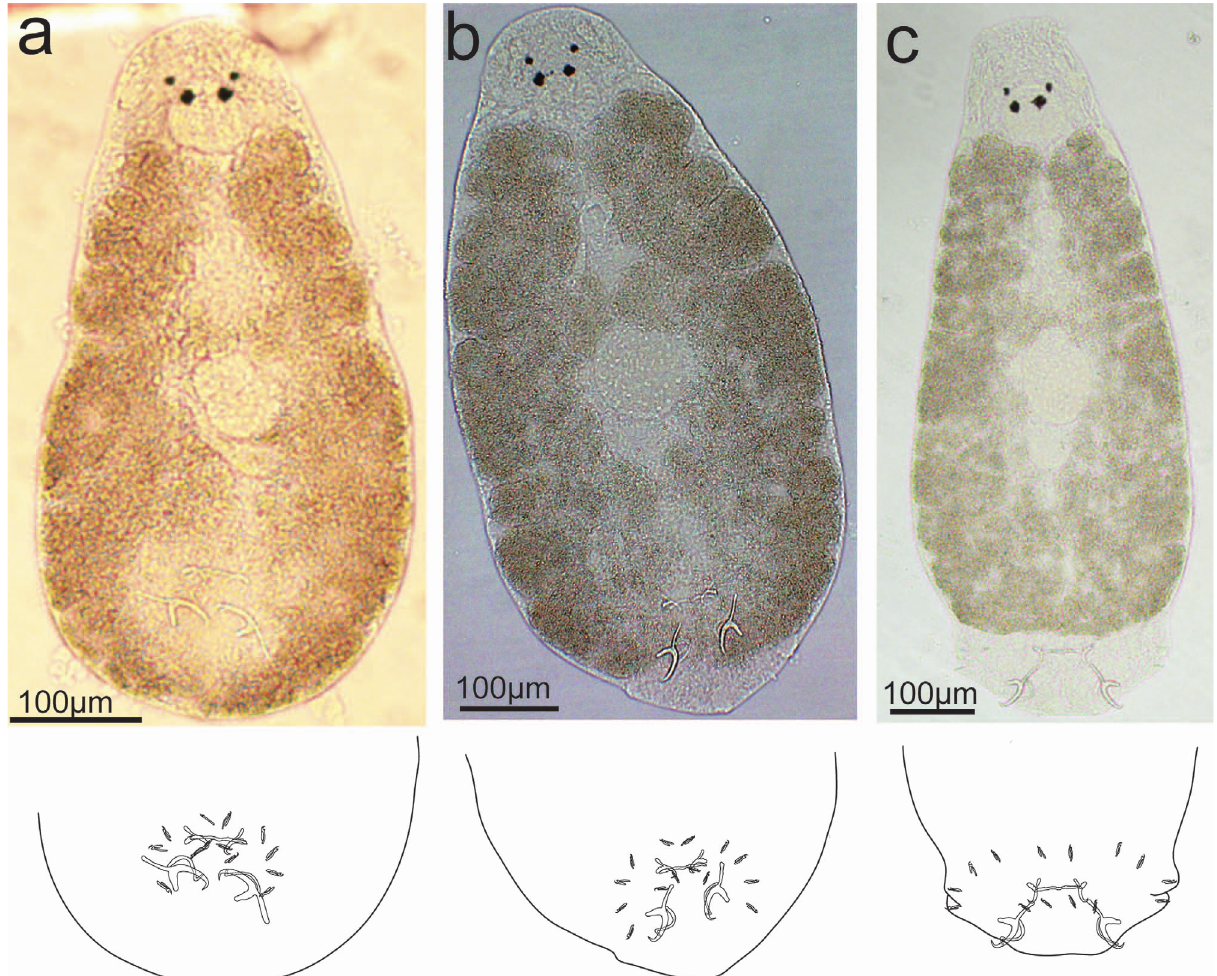
Figure 6. Different body shape of E. malmbergi Bilong Bilong, 1988 under coverslip and the motion of opisthaptoral sclerotized parts depicted in drawings. (a) Cup-shaped body (retracted); (b) interim body shape; (c) cup-shaped body